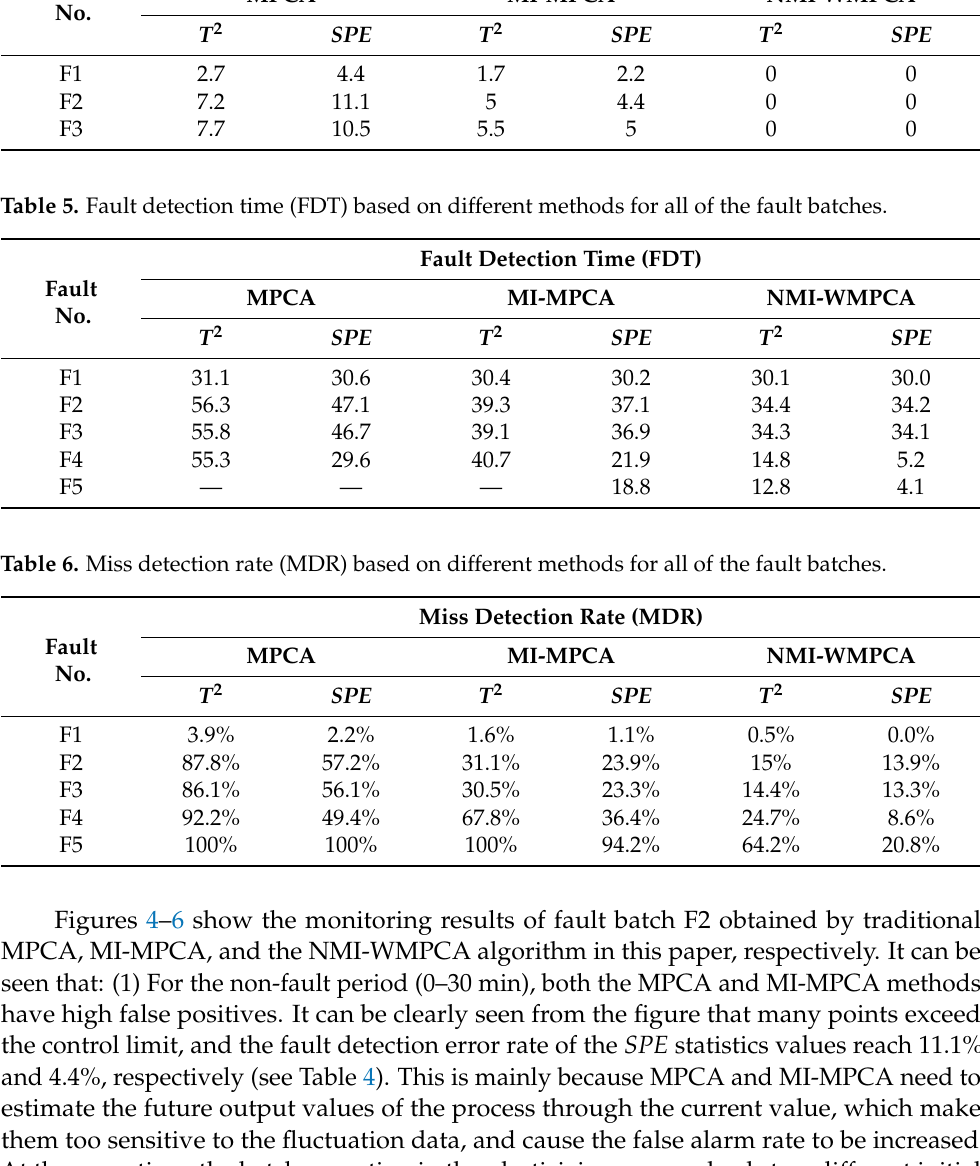
Table 4. Fault detection error rate (FDER) based on different methods for the first three fault batches. FDER (%) Fault MPCA MI-MPCA No.